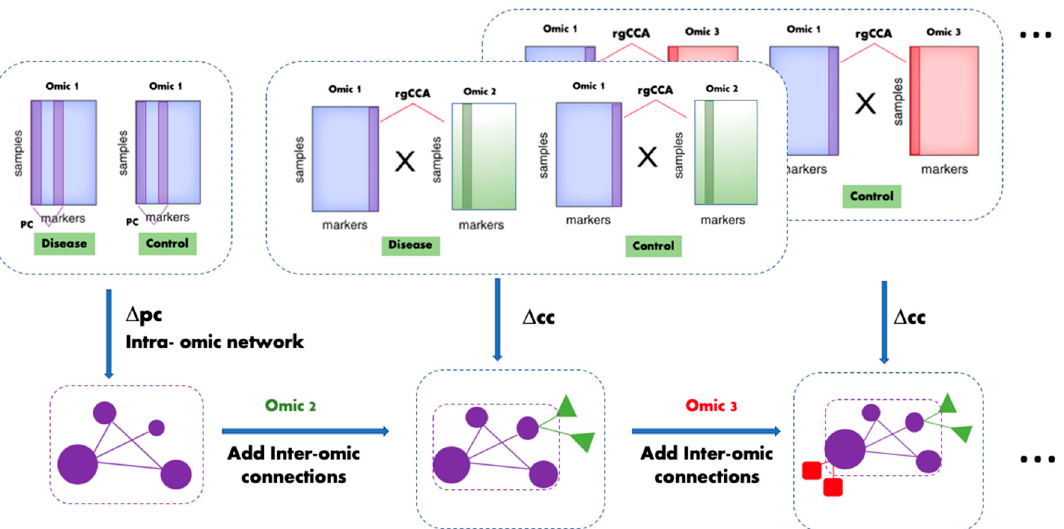
Figure 1. Framework of Multi-Omic inTegrative Analysis (MOTA), demonstrating how an intra-omic network is constructed based on data from Omic 1 and other omic datasets (Omic 2 and Omic 3) to add inter-omic connections to the network. The resulting network allows us to rank disease-associated molecules from Omic 1. Partial correlation ( pc ) is calculated for feature pairs in the Omic 1 dataset, and ∆ pc is used to determine intra-omic connections. For other omic datasets, canonical correlation ( cc ) is calculated for feature pairs between Omic 1 and other omic datasets (e.g., Omic 2, Omic 3, etc.), and ∆ cc is used to determine inter-omic connections. The MOTA activity score of a node is calculated based on the network topology and statistical significance of the feature represented by the node itself and other features whose nodes (from any of the omic datasets) are connected to it.